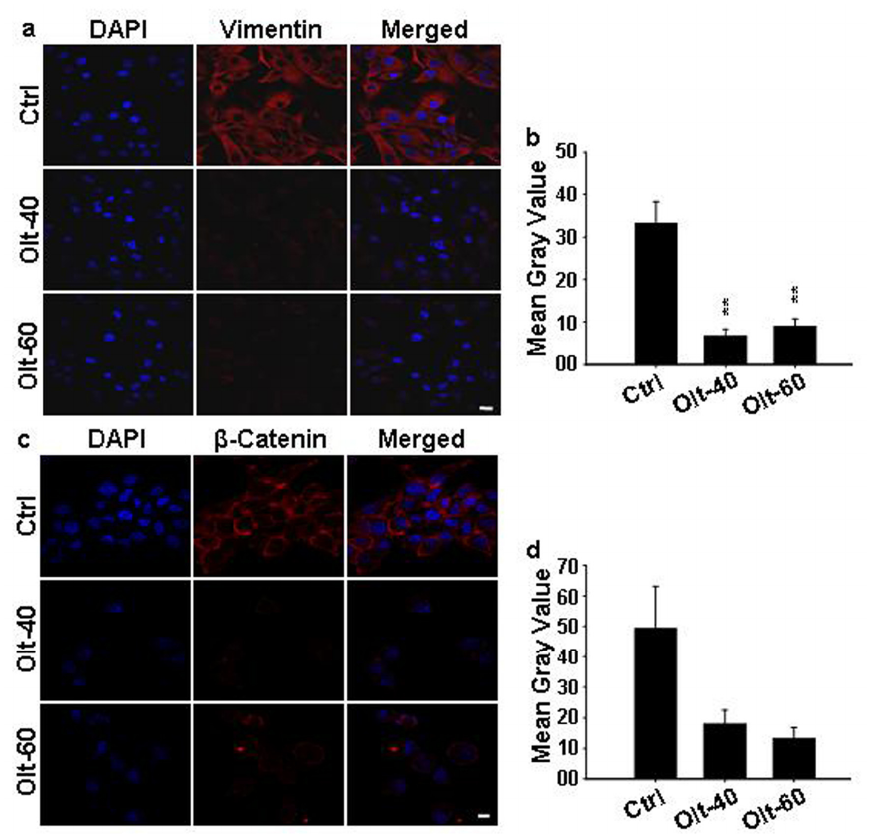
Figure 5. Influence of Olt on EMT reversal : ( a , c ) Immunofluorescence examination of EMT marker vimentin ( a ) and β -catenin ( c) expression in U-87 MG cells revealed a reduction in the same following their exposure to Olt. Scale bar: 20 µ M. ( b , d ) Respective intensity quantification from ( a ) and ( c ) (from 3 different fields). Data are presented as mean ± SEM (n = 3–4). ** p ≤ 0.01.